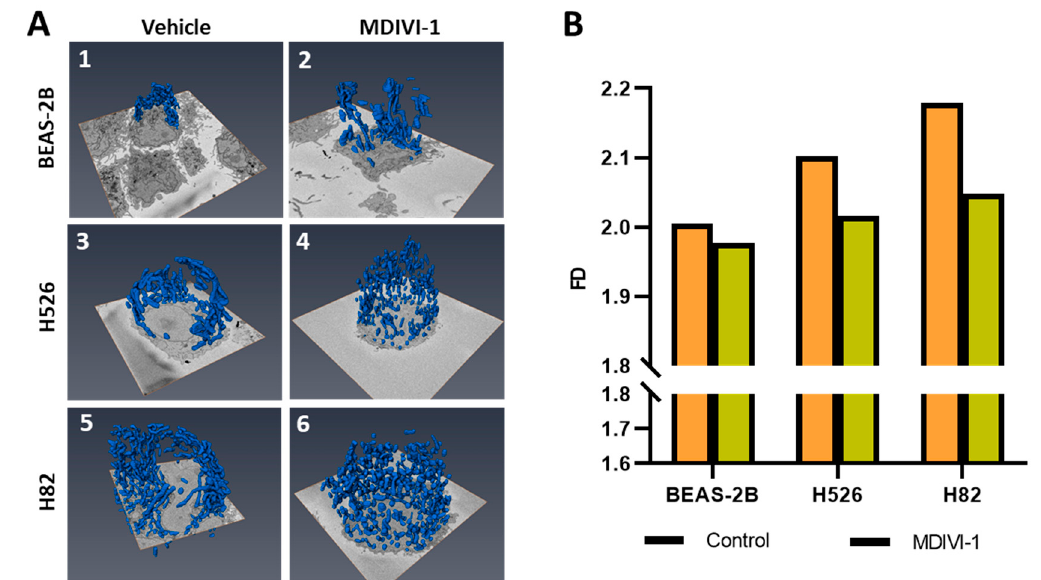
Figure 6. 3-D reconstruction of mitochondrial network morphology with and without MDIVI-1 treatment: ( A ) We employed serial block-face scanning electron microscopy. We utilized three cell lines BEAS-2B normal lung epithelial and H82, H526 SCLC cell lines. The cell lines were observed under field-emission scanning electron microscope (Zeiss Sigma VP) with or without drug treatment (MDIVI-1 20 µM). An automatic microtome took 70-nm thick slices and this was repeated 1000 times to give a data set from which a complete three-dimensional reconstruction could be derived. Panels 1, 3, and 5 showed 3-D mitochondrial morphology in control BEAS-2B, H526, and H82, respectively. Patterns of the mitochondrial 3-D network in BEAS-2B and SCLC cells after MDIVI-1 treatment is shown on panels 2, 4, and 6. ( B ) Mono-fractal analysis of the 3-D reconstruction of the mitochondrial network in BEAS-2B, H526, and H82 cells.